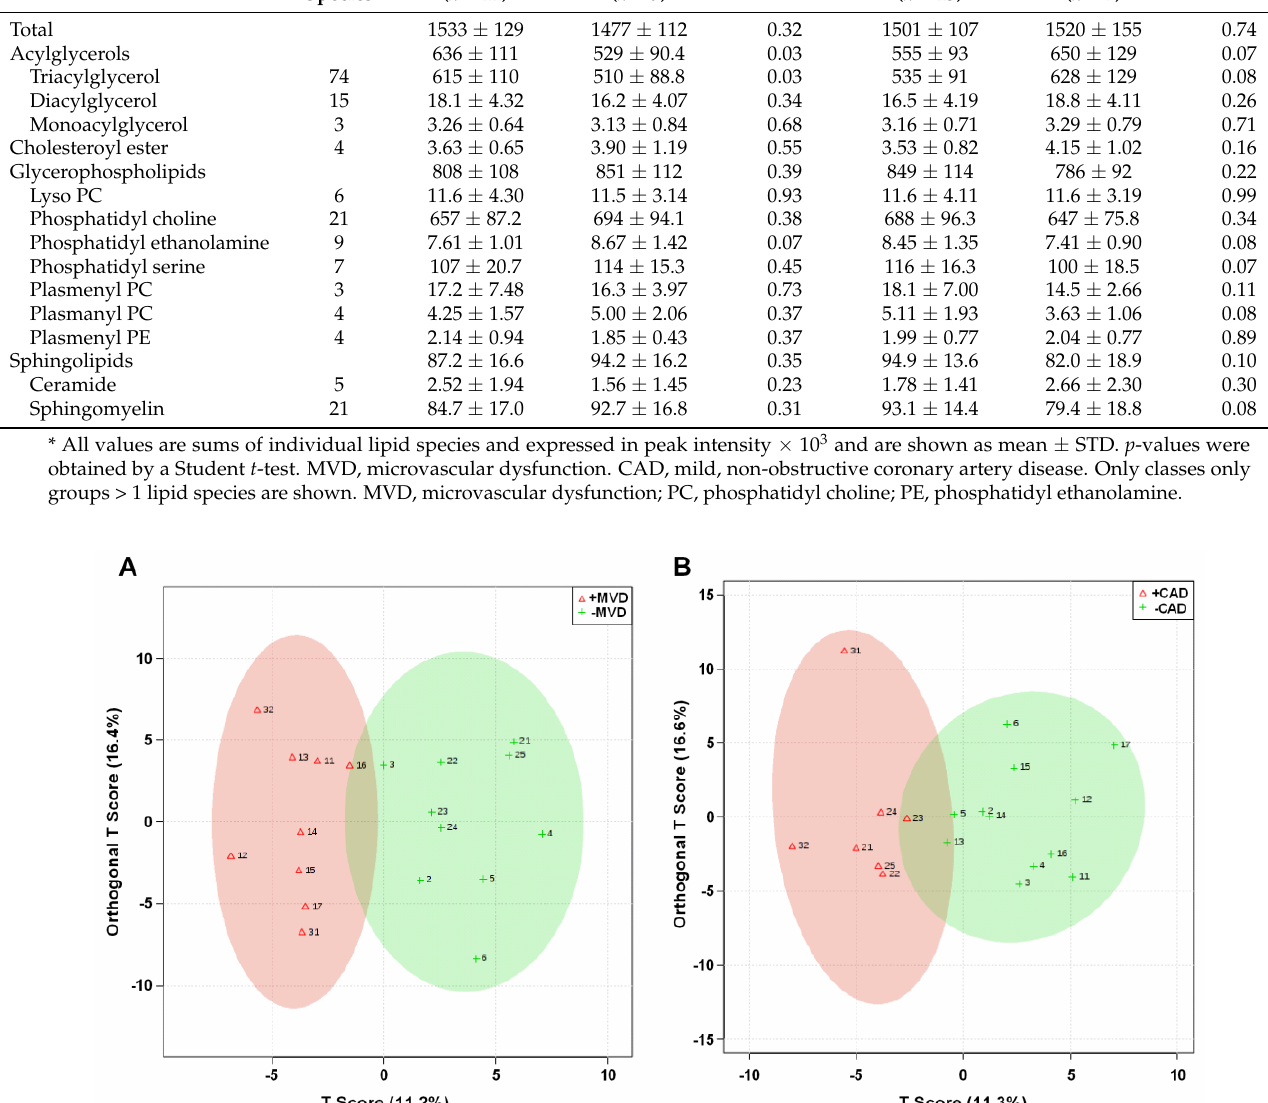
Table 4. Plasma lipid class levels of participants by microvascular dysfunction (MVD) and non-obstructive CAD *. Lipid Class